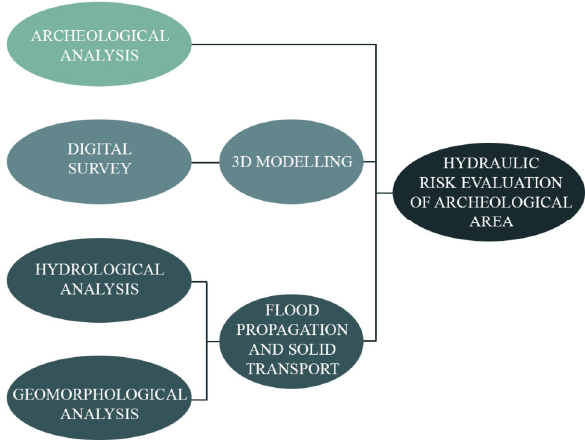
Figure 2 . Methodological pipeline.